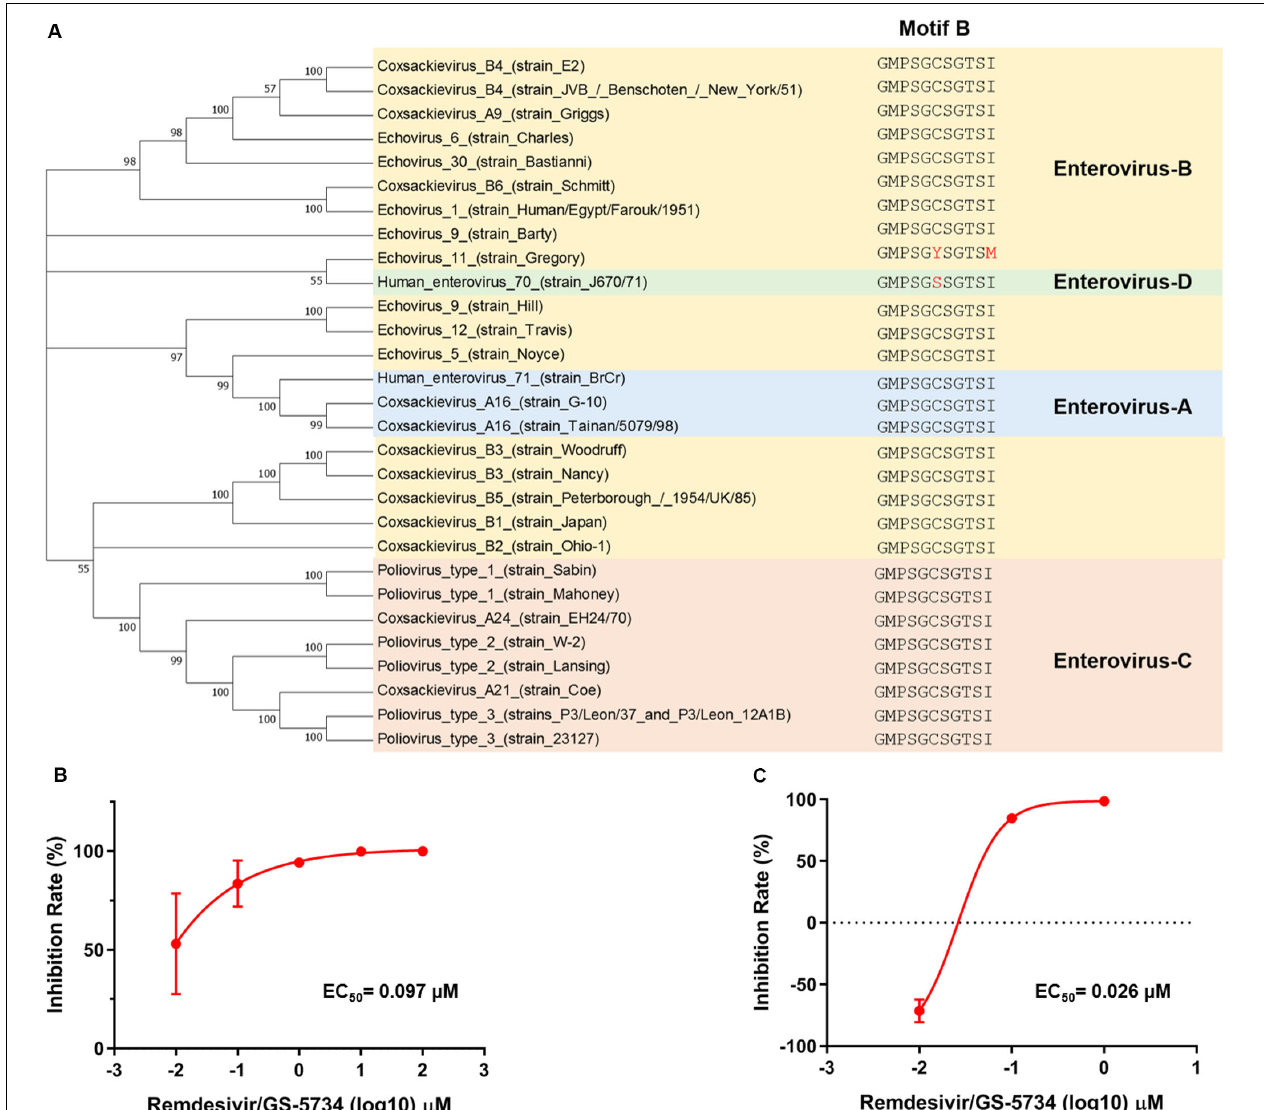
FIGURE 4 | Remdesivir exhibits broad-spectrum inhibition of enterovirus replication. (A) Phylogenetic analyses of the human enterovirus amino acid sequence. EV-A is marked in light blue, EV-B is marked in gold, EV-C is marked in orange, and EV-C is marked in green. CVB3 (B) and EV70 (C) RNA synthesis was inhibited by remdesivir (mean ± SD, n = 3). * P < 0.05, *** P < 0.001, and **** P <